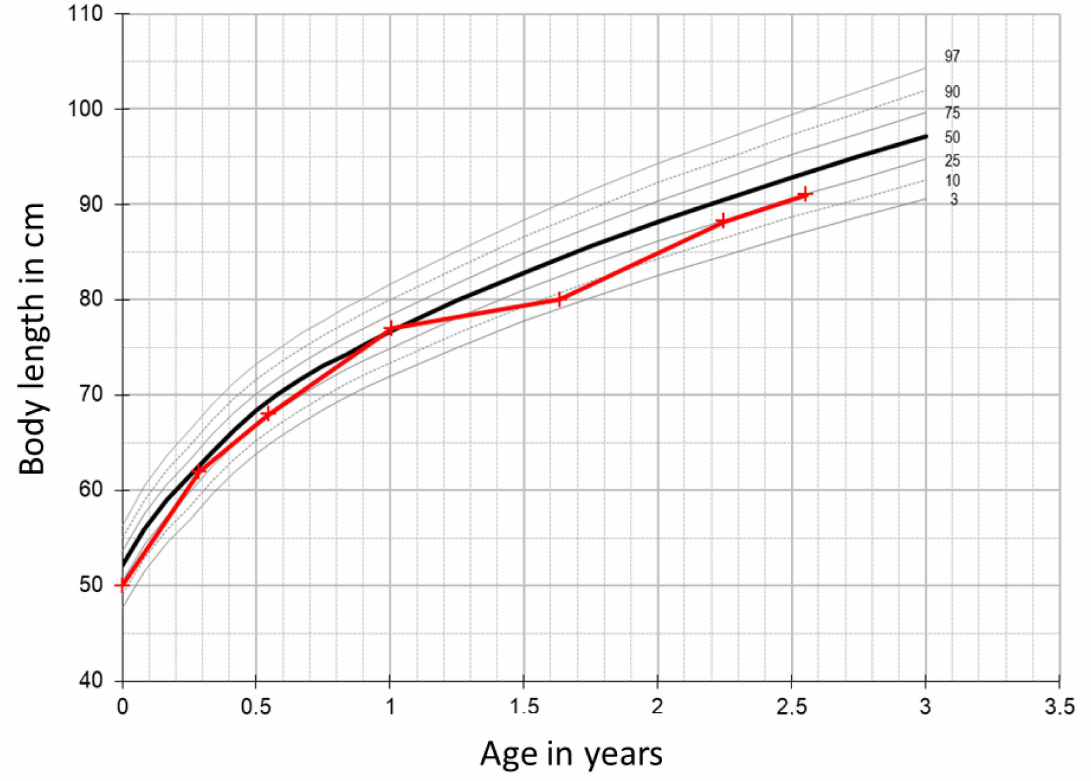
Figure 1. Growth chart of the patient. The boy was not small for gestational age, and his further growth was within the lower normal